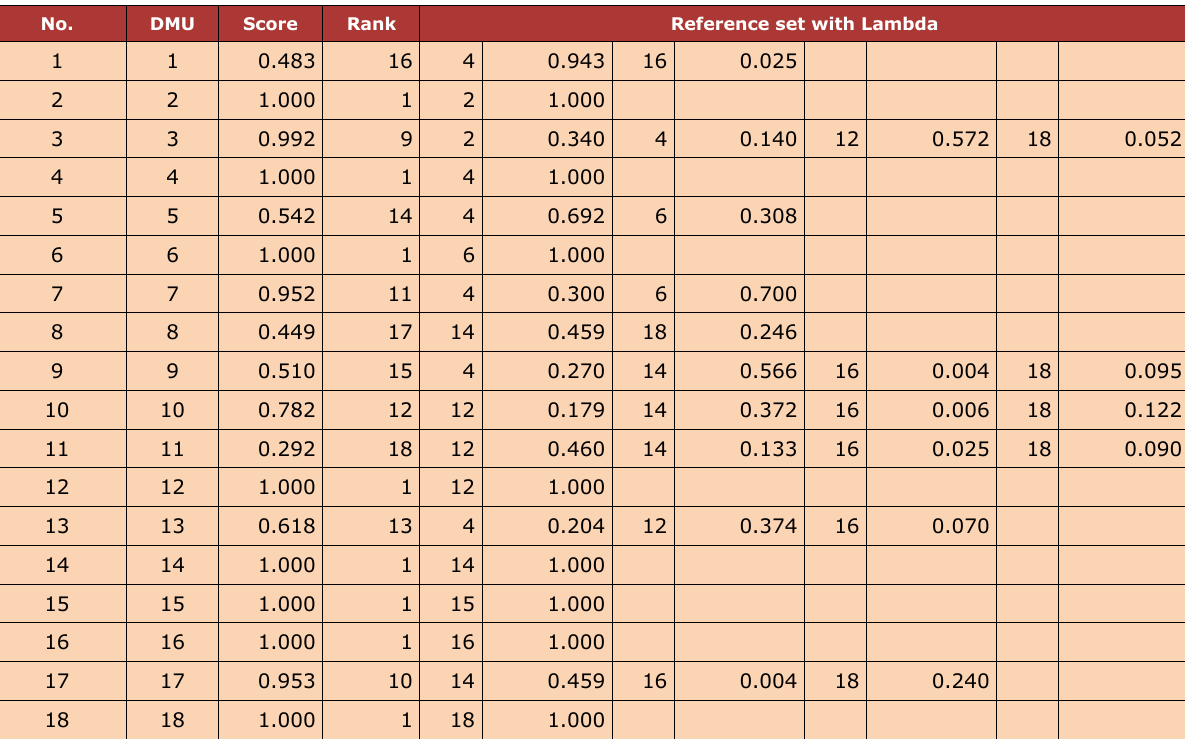
Table 9. Efficiency and reference set